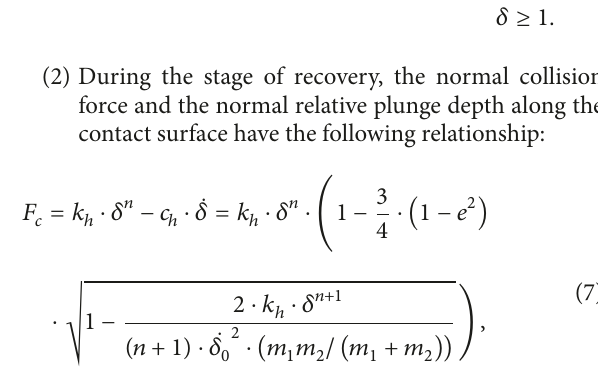
Figure 2: Hertzdamp